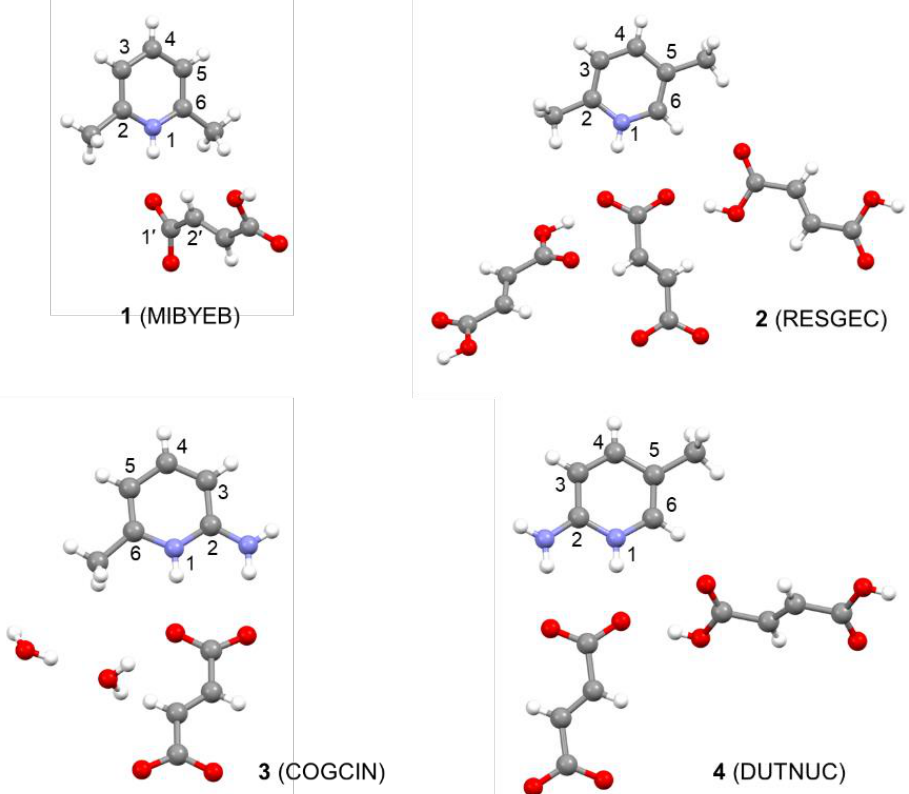
Figure 1. The structures of the systems studied together with their CSD ref codes (in parentheses) from the Cambridge Crystallographic Database [30] and atom numbering. Note that we employ the standard numbering of organic compounds and that the atom numbers differ from those used previously [18] .